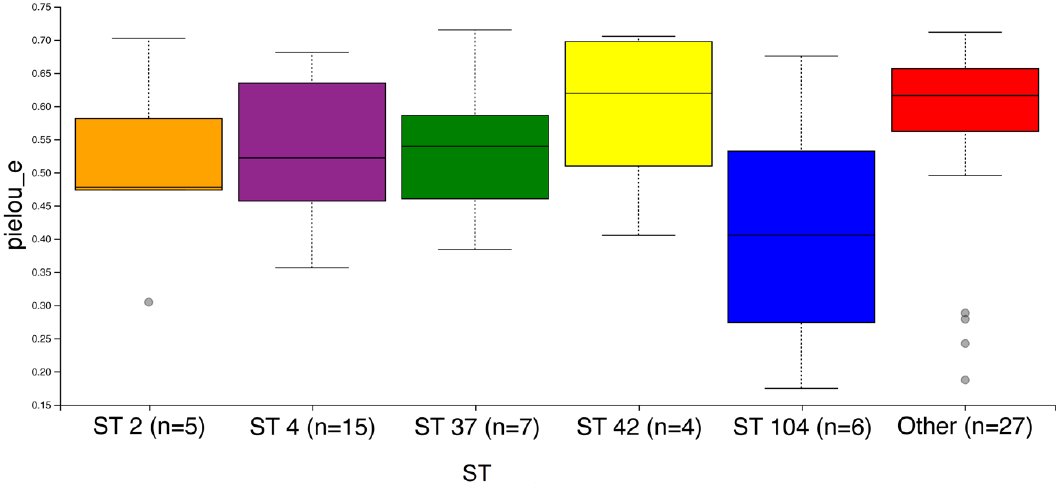
Figure 2. Pielou’s Evenness plot, a measure of community evenness among the different STs.